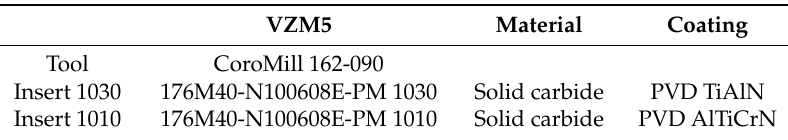
Table 2. Used tool and insert types.